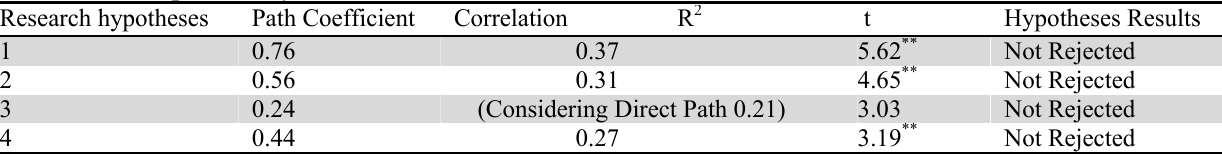
The results of path